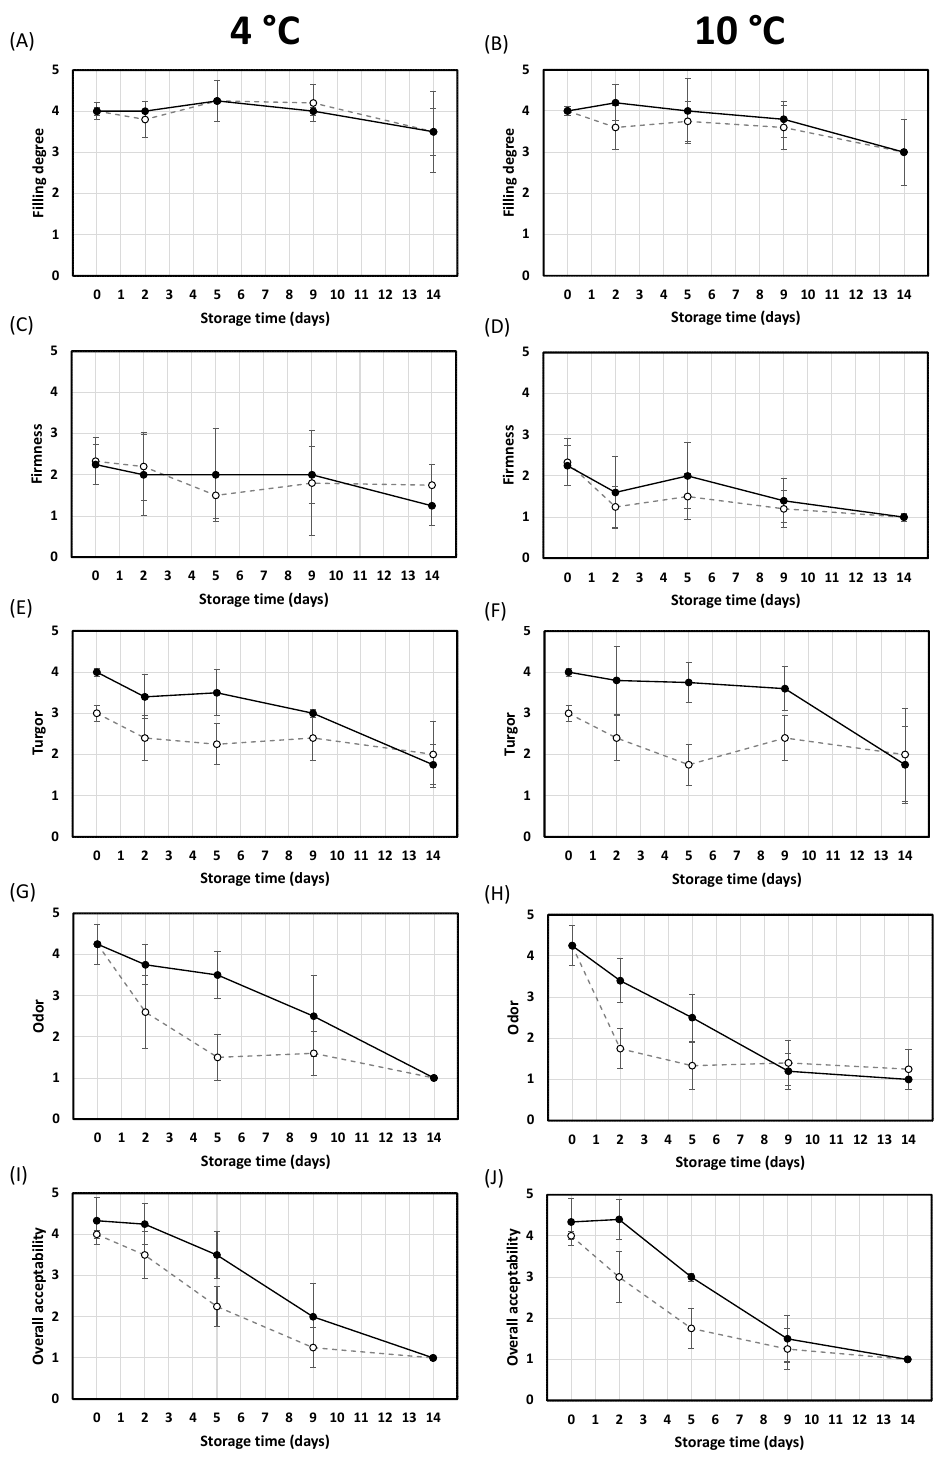
Figure 3. Evolution of the sensory quality (filling degree, firmness, turgor, odor and overall acceptability) during the storage at 4 °C ( A , C , E , G and I , respectively) and 10 °C ( B , D , F , H and J , respectively) of the oysters treated by HPP at 300 MPa for 2 min (closed symbols) and the respective controls (opened symbols). All values are means ± 95% CI ( n = 7).